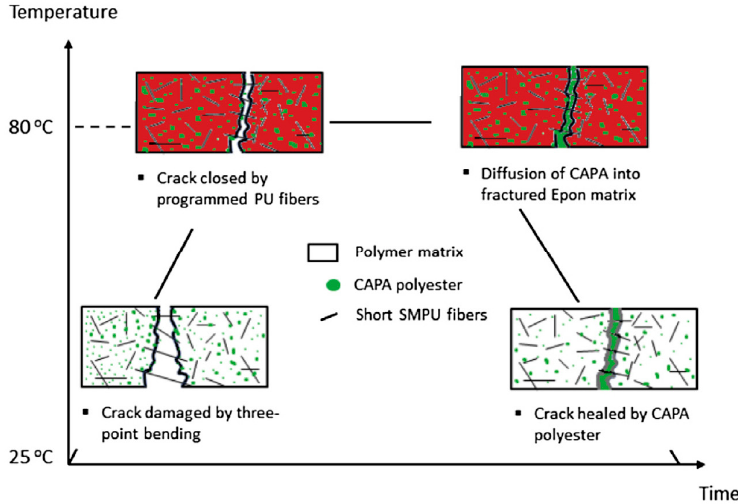
Figure 4. Schematic of the two-step healing process (i.e., close-then-heal) in a fractured short SMPU fibre-reinforced specimen ([102], reproduced with permission from Elsevier). fibre-reinforced specimen ([102], reproduced with permission from